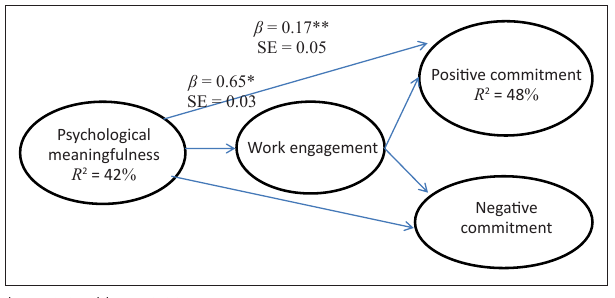
Figure 1: The structural model FIGURE 1 : Structural model of meaningful work .